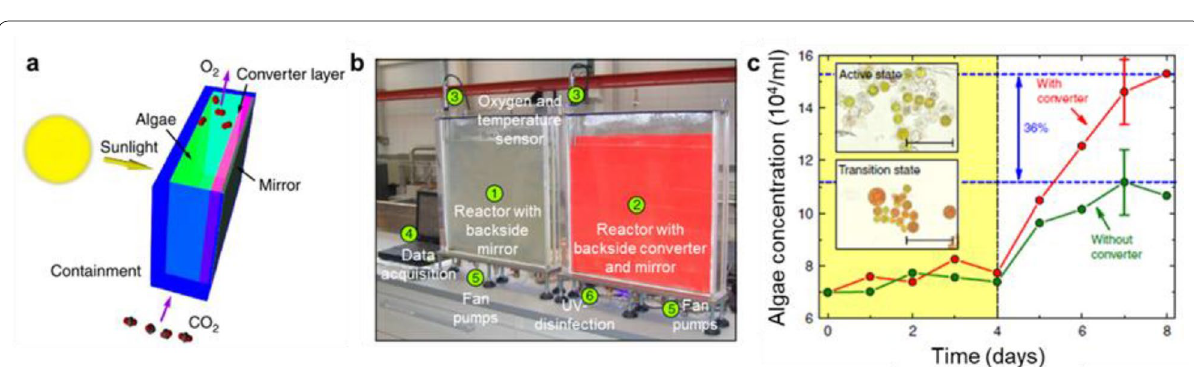
Fig. 9 a Photobioreactor that is combined with a solar spectral converter in backlight geometry. b Photograph of the flat panel photobioreactor set-up. c Algae concentration as a function of time. Reproduced with permission from